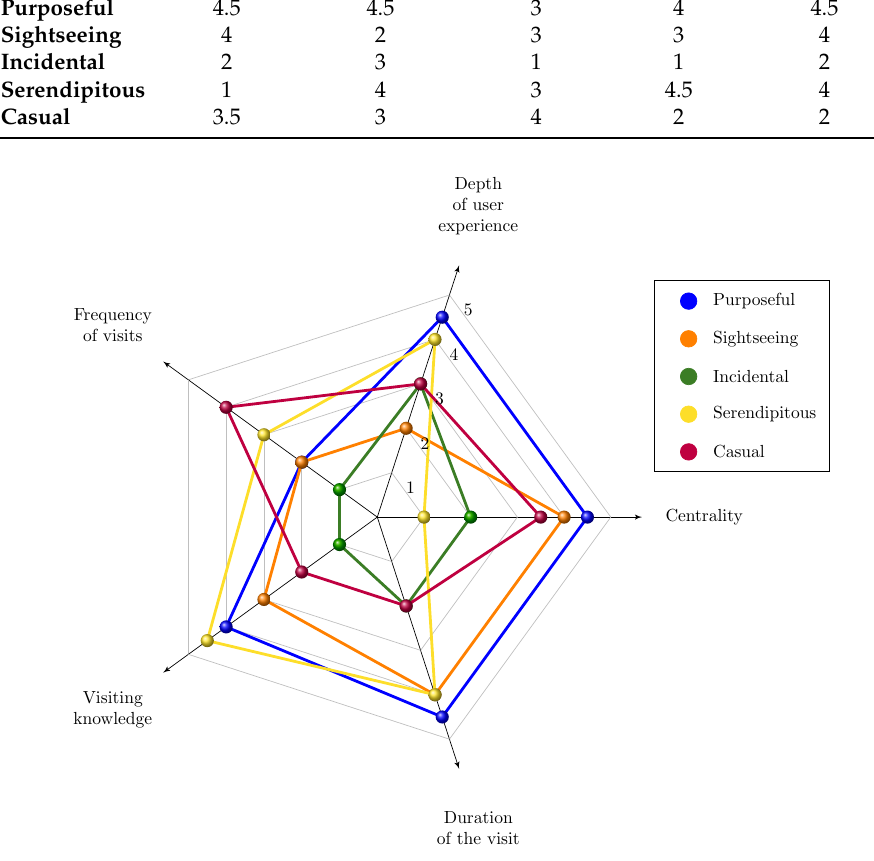
Figure 2. Cultural tourist Kiviat